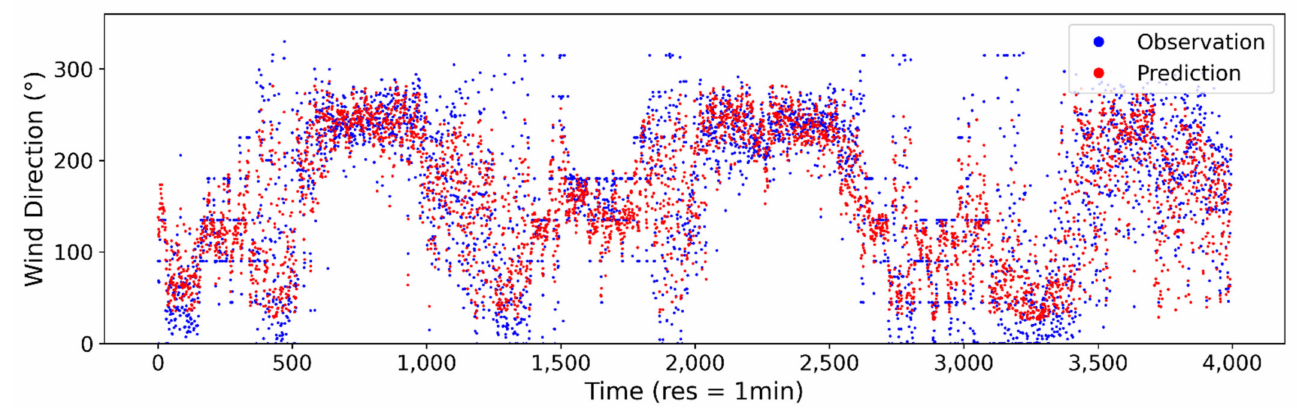
Figure A7. Estimated vs. observed wind direction at 1-min sampling interval using ANN